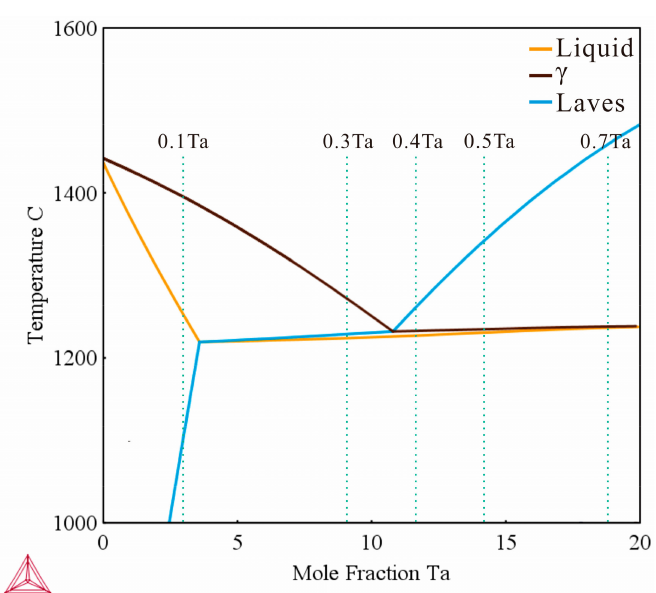
Figure 1. The pseudo binary phase-diagram of CrCoNiTa x alloys calculated from Thermo-Calc.